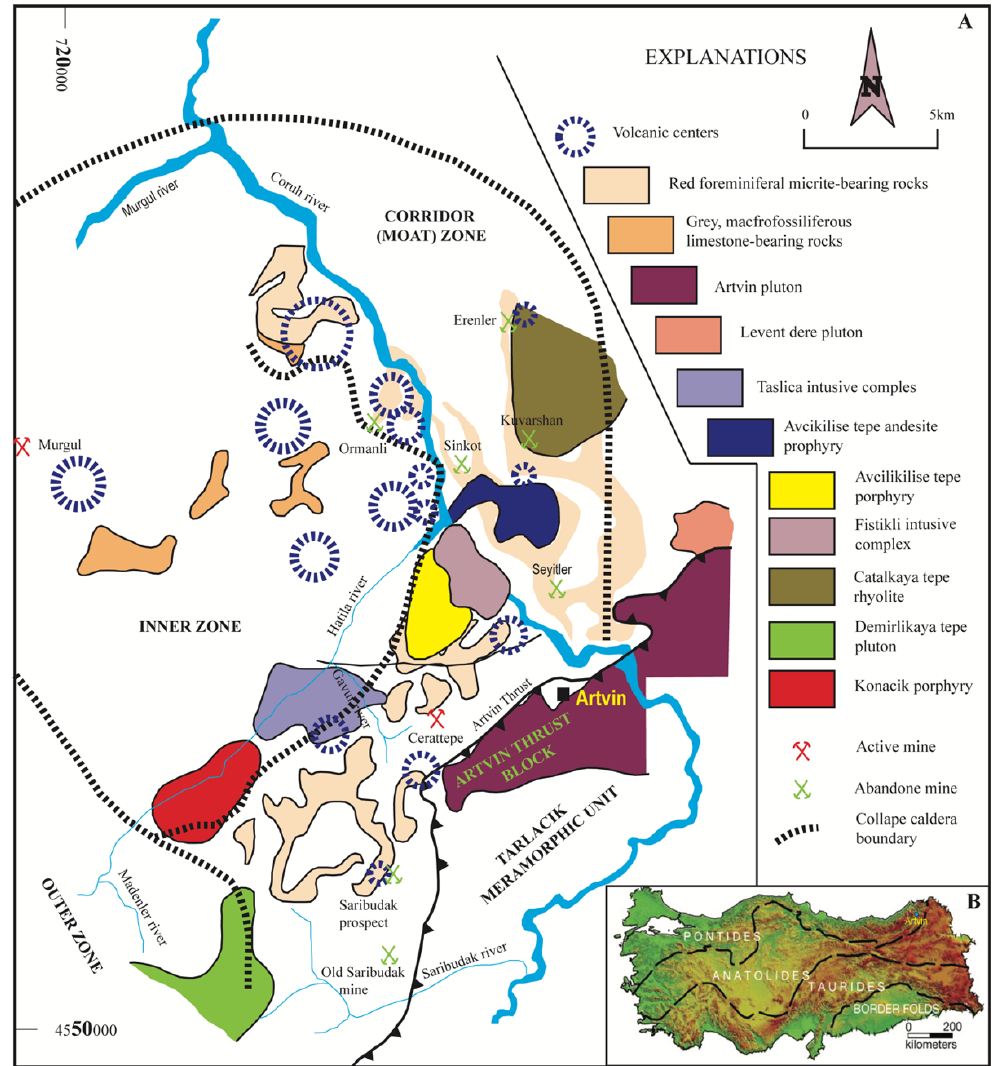
Figure 2. ( A ) Simple geological and location map of VMSD in Artvin area and volcanic architecture and surround intrusion and volcanic rocks with volcanic centers, modified from [22], ( B ) Main tectonic units and location of Artvin province after [1].